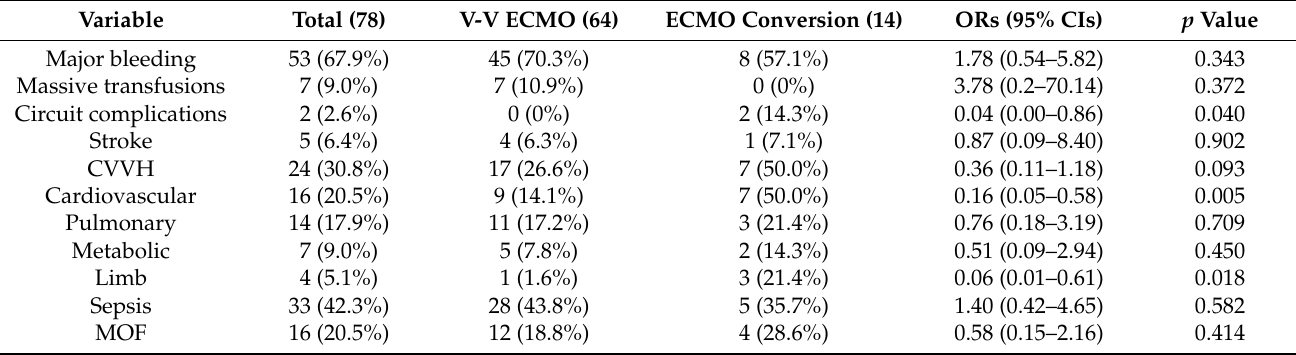
Figure 2. Survival comparison between veno-venous ECMO and more advanced ECMO support configuration forms. ECMO, extracorporeal membrane oxygenation. Table 3. Complications.